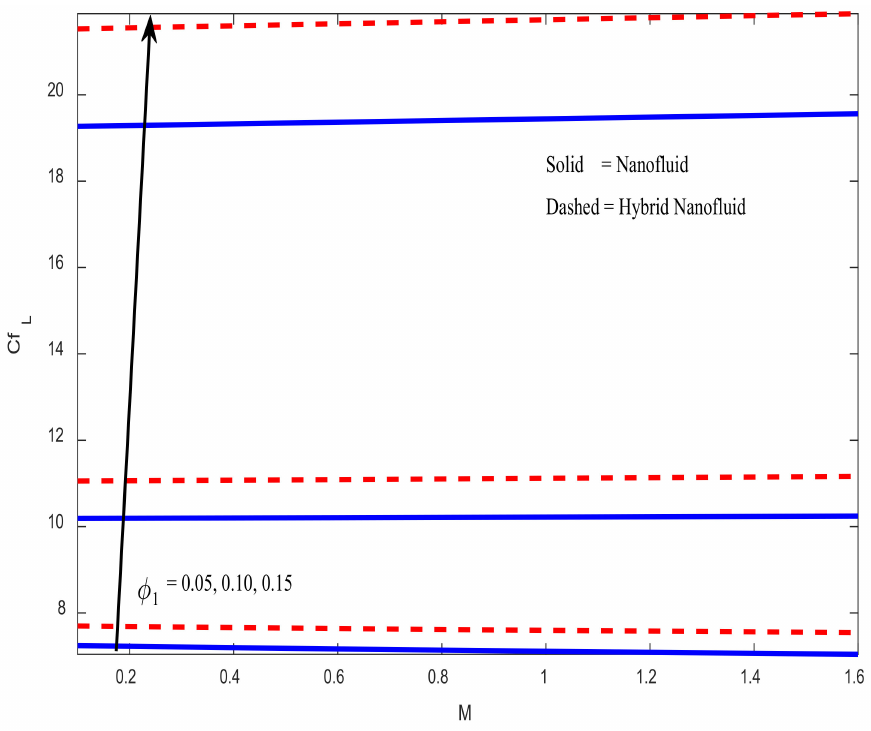
Figure 12. Influence of φ 1 on skin friction coefficient near the lower wall.